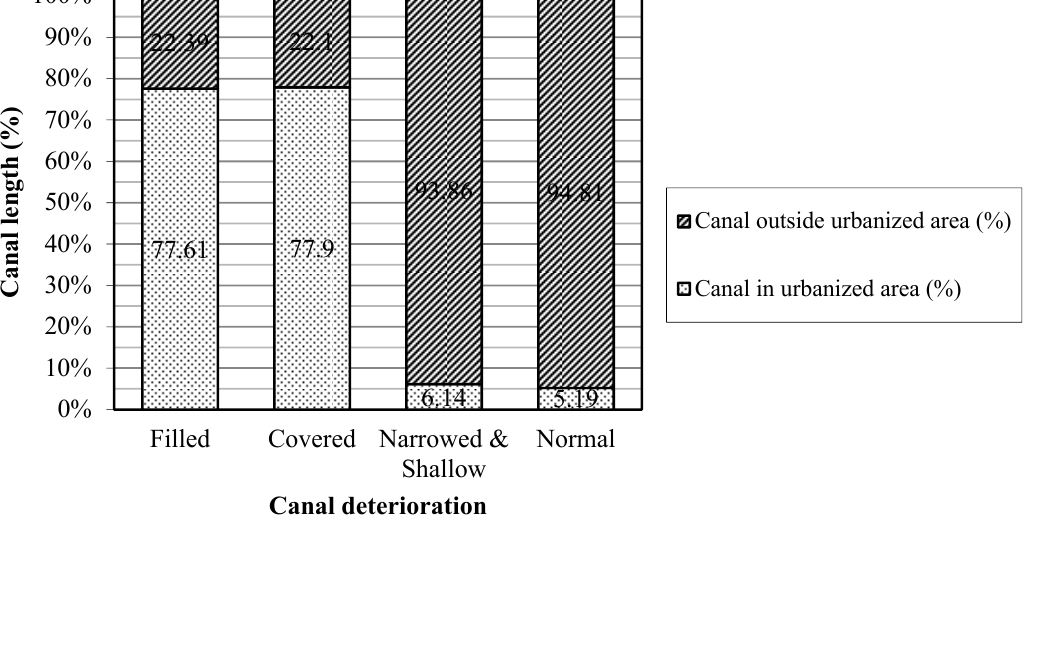
Figure 6. Percentage of canal deterioration located inside and outside urbanized